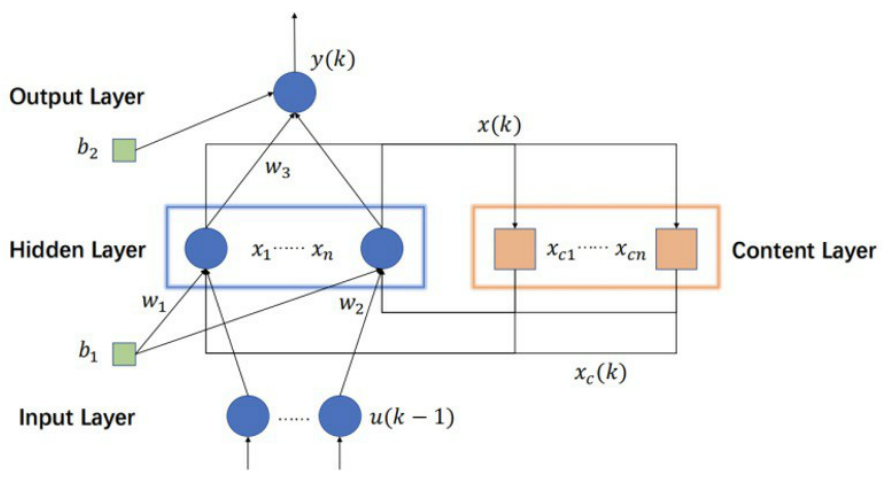
Figure 1. The structure of the Elman neural